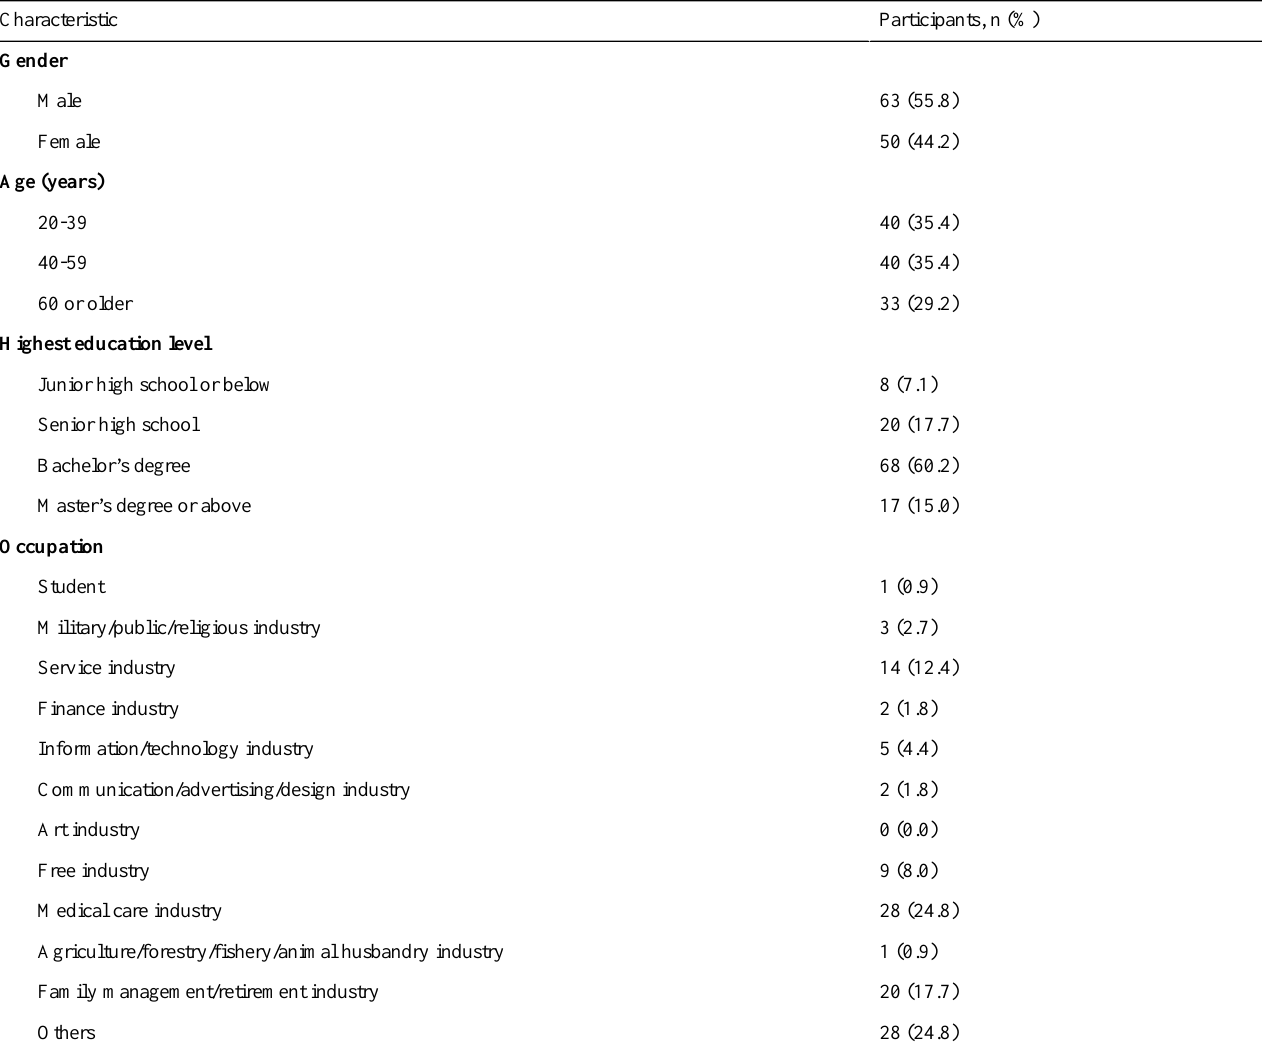
Table 1. Characteristics of the participants